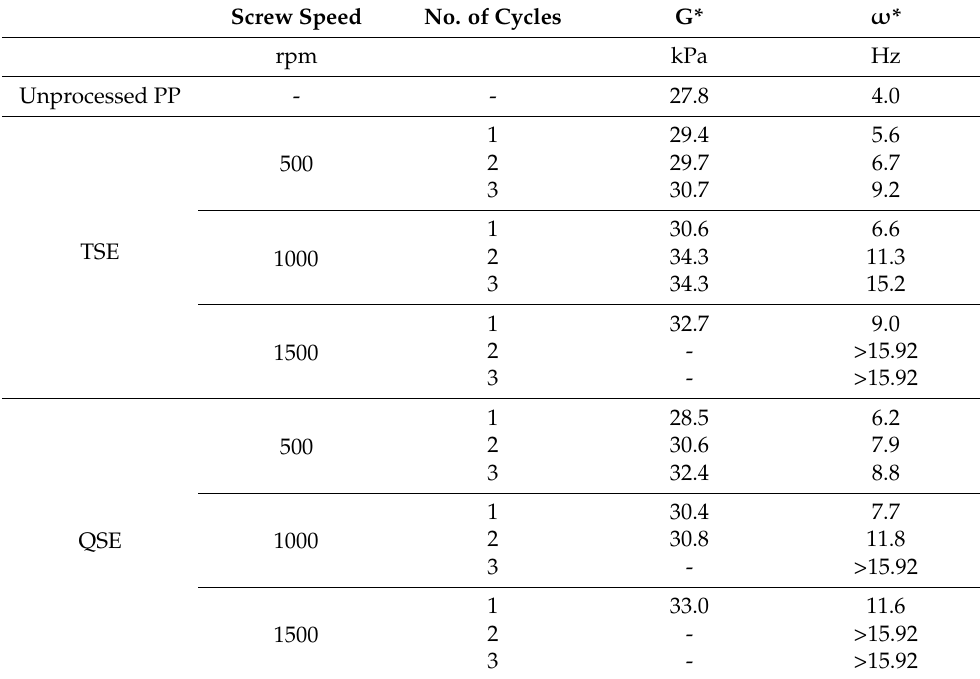
Table 1. Crossover point (G*) and angular frequency ( ω *) at G (cid:48) = G (cid:48)(cid:48) for the PP samples reprocessed using the TSE and QSE. Screw Speed No. of